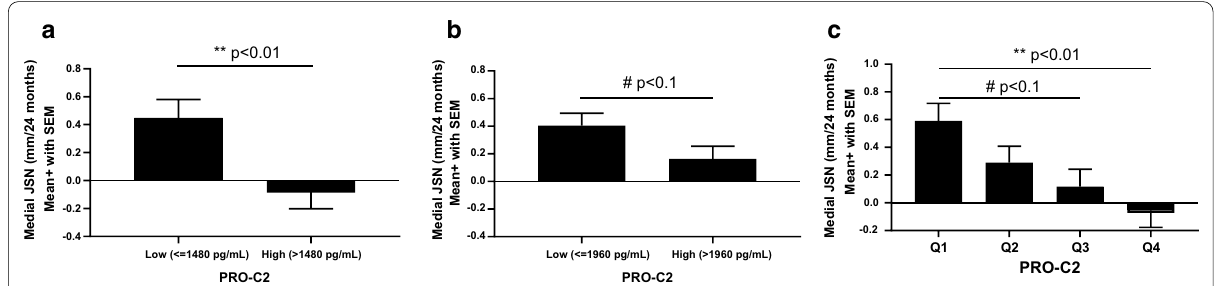
Fig. 2 Association between baseline levels of PRO‑C2 and 2‑year radiographic progression (JSN). Patients were dichotomized based on the median to low and high levels of PRO‑C2 and the degree of progression was compared in a the NYU and b the SMC cohort. c Assessment of “dose–response” of JSN as a function of PRO‑C2 levels in the combined dataset (all subjects in NYU cohort and the placebo arm of SMC subcohort). Analyses were adjusted for age, BMI, gender, VAS pain, and baseline medial JSW using two‑way analysis of covariates (ANCOVA). Data are presented as mean with standard error of mean (SEM). Asterisks: ** p < 0.01; # p <